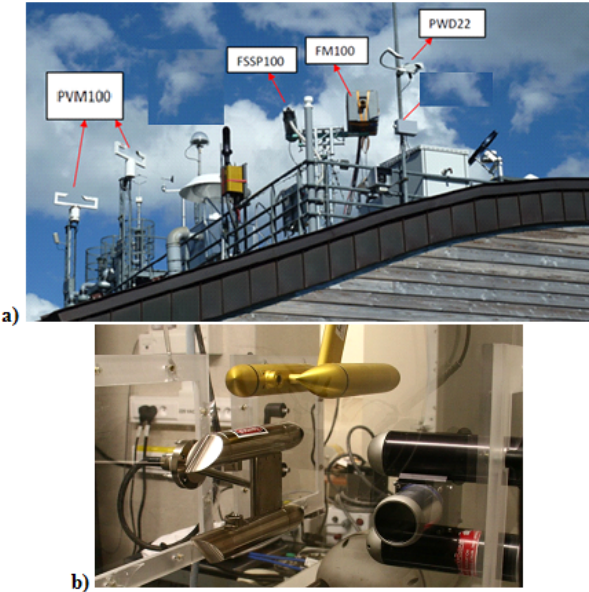
Figure 1. (a) Instruments set up on the roof. The FSSP and the FM- 100 were placed on the mast, which can be oriented manually, so the direction in which these two instruments are pointed can be chosen and (b) instruments set up in the wind tunnel: the SPP on the right, the CDP 1 on the top and the CDP 2 on the